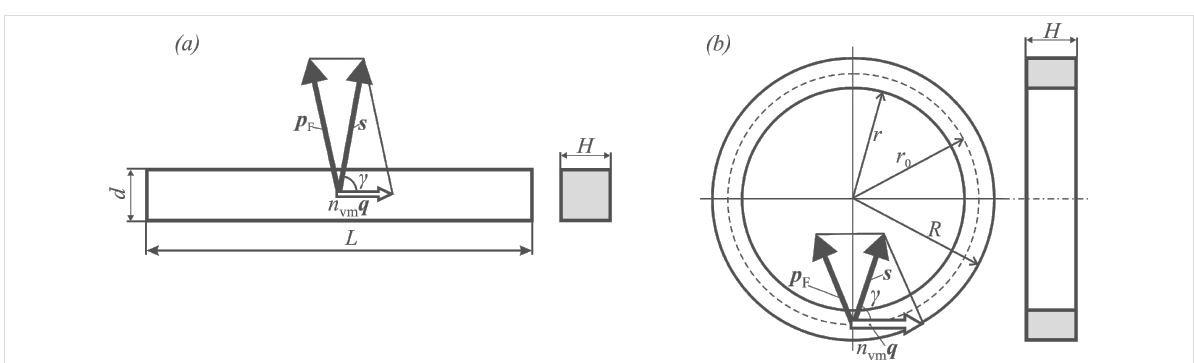
Figure 3: Geometry of nanoobjects and phonon/electron momenta in GNB (a) and in GNR (b). For simplicity, the momentum p ph of the microwave photon is omitted, by force of relations , . Note that the compression wave may travel in both directions along the bar or the ring, whereas the propagation of excited electrons is confined along the conical surfaces with large opening angle, 2 γ ≈